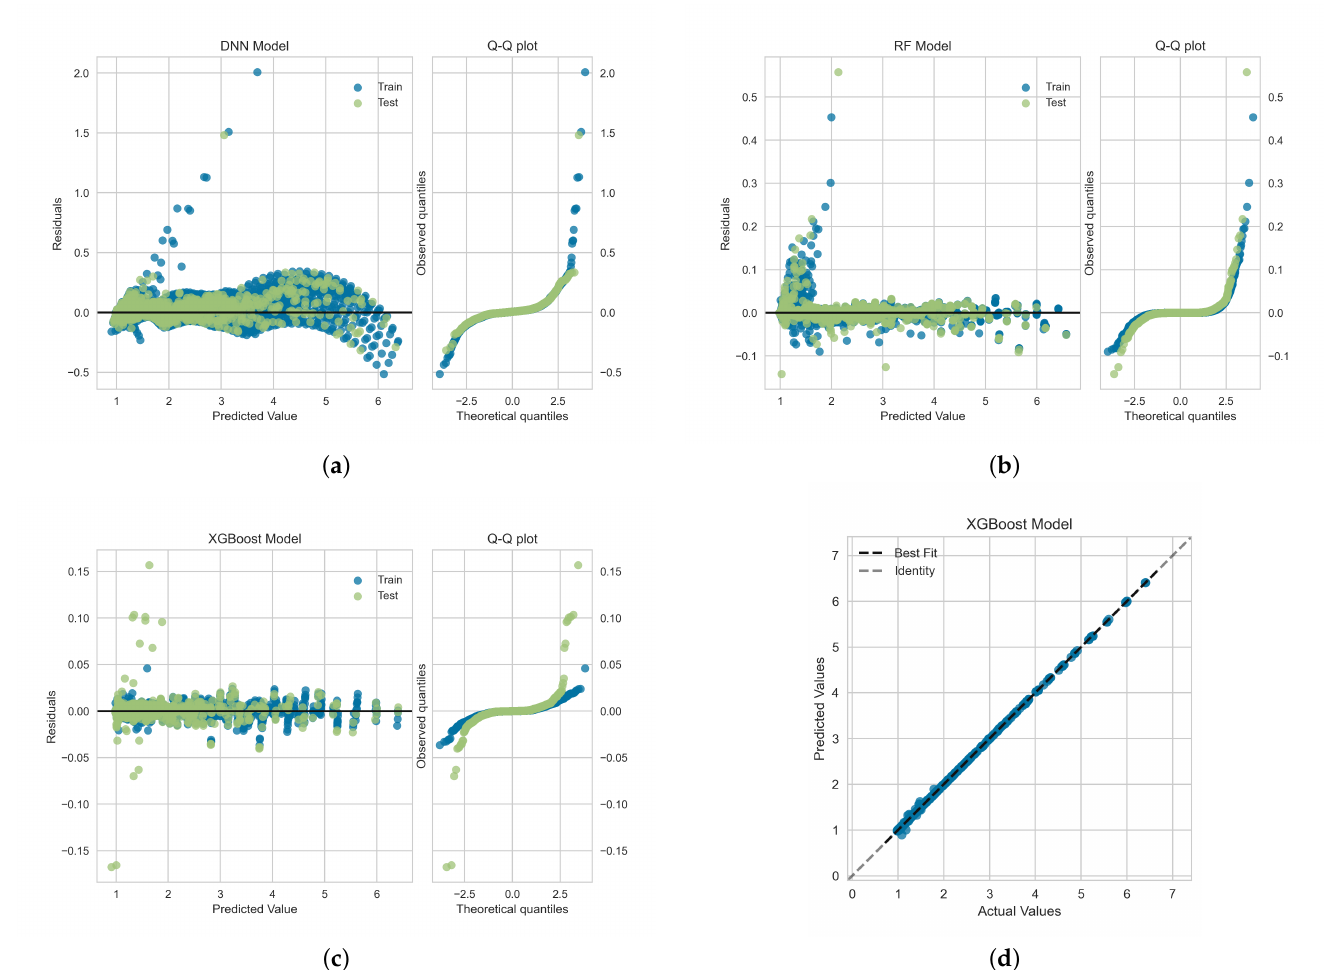
Figure 9. Residuals and quantile-quantile (Q-Q) plots obtained for the ML algorithms trained, validated and tested on the OB-set : ( a ) Neural Network, ( b ) Random Forrest, and ( c ) XGBoost models. Panel ( d ) shows the prediction error plot for XGBoost that yields the highest R 2 as reported in Table 3. The ML models trained on the OB-set fail, as expected, when inferred against a dataset generated for shear thinning fluids (e.g., even at α = 0.1, which is just slightly outside the scope of the OB-set where α is set to zero). To accurately predict the